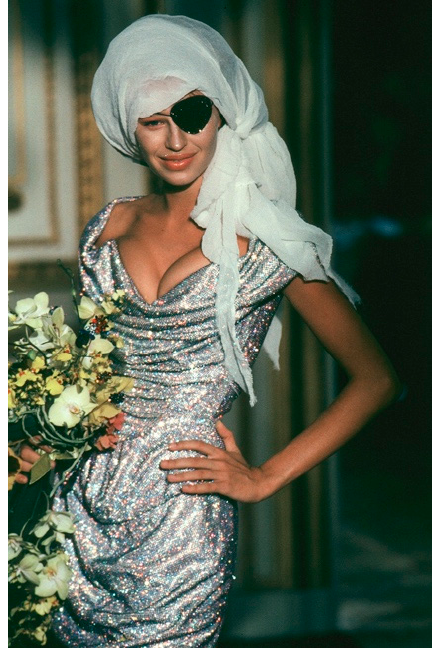
Figure 1. Dress made from diffractive fabric in Vivienne Westwood’s Spring/Summer 1998 collection. (Photo ©FirstVIEW/IMAXtree.com, used with permission.)